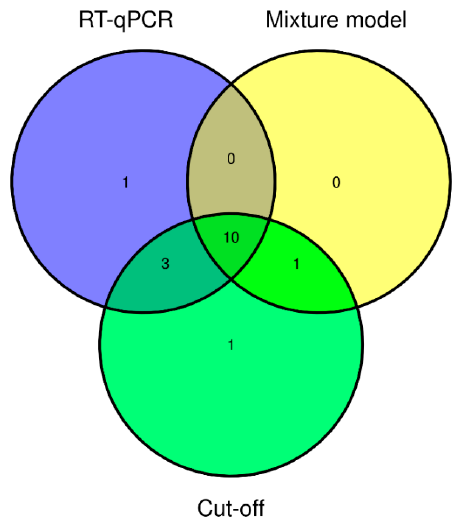
Figure 1. Venn diagram showing the overlap between positive results of SEOV RT-qPCR and ELISA using two different methods to determine seropositivity. Cut-off: average OD of negative control population +/ − 3 × SD.